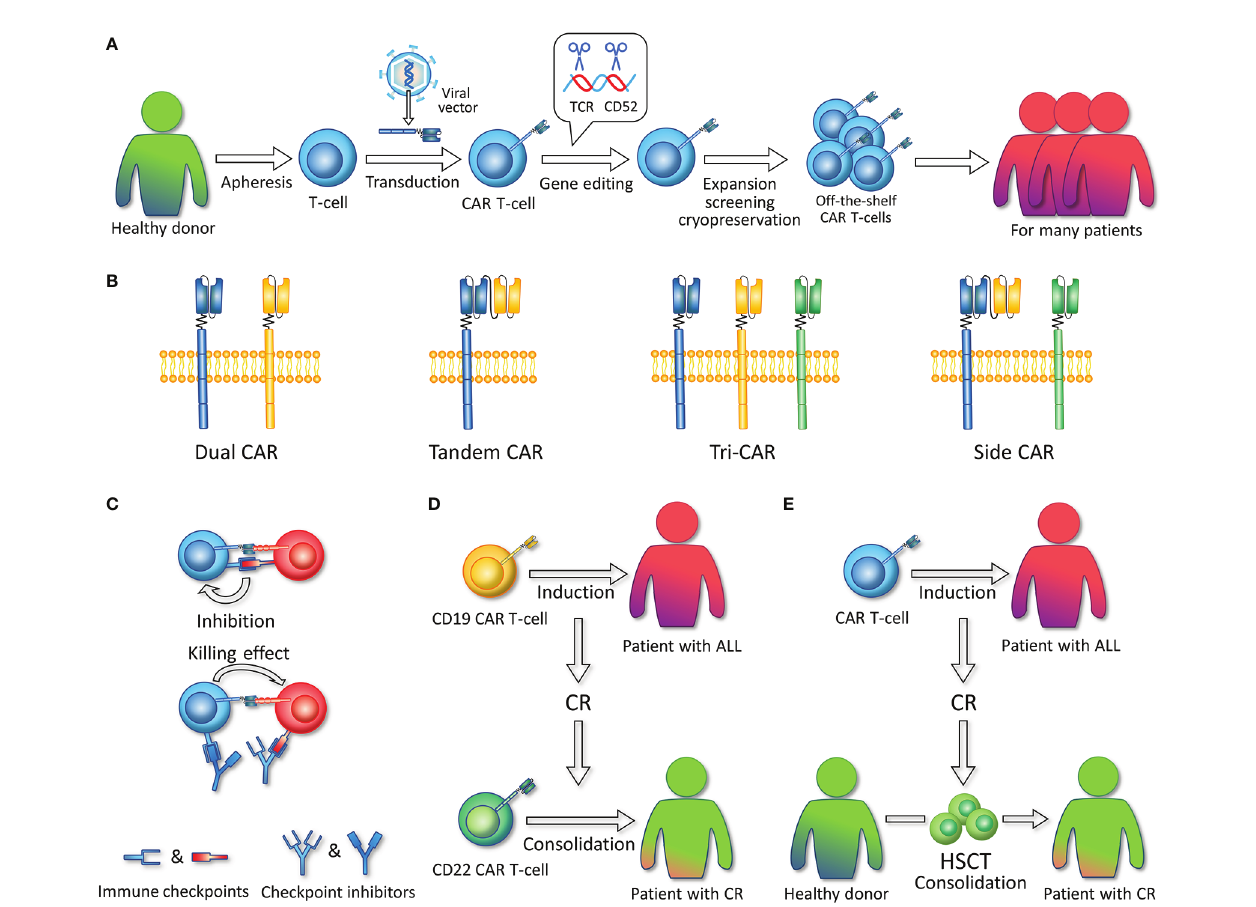
FIGURE 3 | (A) Allogeneic, off-the-shelf CAR T-cells. The fi gure illustrates the general preparation process of allogeneic, off-the-shelf CAR T-cells. T-cells are extracted from healthy donors. Viral vectors are used to introduce CAR-encoding genes into T-cells. Gene editing technology is used to remove the gene fragments encoding TCR and CD52. CAR T-cells are expanded, screened, and cryopreserved. These CAR T-cell products can serve as timely treatment for many patients. (B) Multi-antigen targeted CAR. Dual CAR refers to two different mono-CARs in one T-cell. Tandem CAR refers to a CAR structure that contains two single-chain variable fragments. Tri-CAR T-cell coexpresses three different mono-CARs on a single T-cell. Side CAR T-cell expresses a Tandem CAR and a mono-CAR. (C) In combination with immune checkpoint inhibitors. Immune checkpoint inhibitors such as PD-1/PD-L1 inhibitors can speci fi cally block the binding of CAR T-cell or ALL- expressed immune checkpoint molecules to the corresponding receptors on CAR T-cells, thereby enabling CAR T-cell activation and the killing of tumor cells. (D) Sequential infusion. CD19 CAR T-cells are fi rst infused to induce CR, and after patients achieve CR, CD22 CAR T-cells are infused as consolidation. (E) Bridging to HSCT. CAR T-cells are infused to induce CR, and after patients achieve CR, hematopoietic stem cell transplantation (HSCT) is conducted as